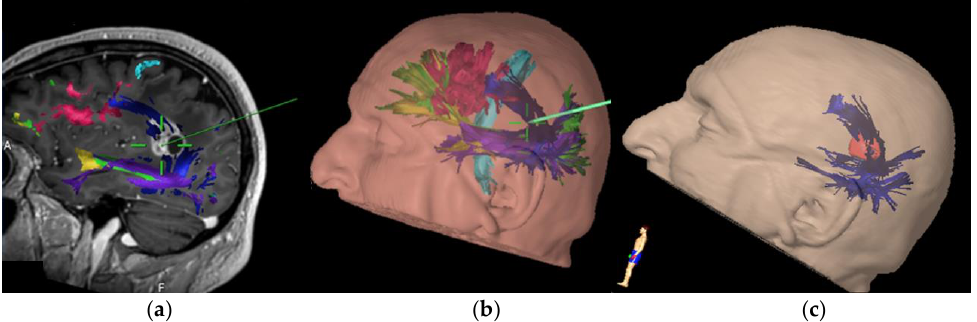
Figure 1. Intraoperative screenshots with navigated tractography of left temporo-parietal high-grade glioma involving the middle part of AF ( a ) T1 contrast enhanced MRI; ( b ) 3d volume rendering with coloured tracts; ( c ) 3d volume rendering with AF and tumor.